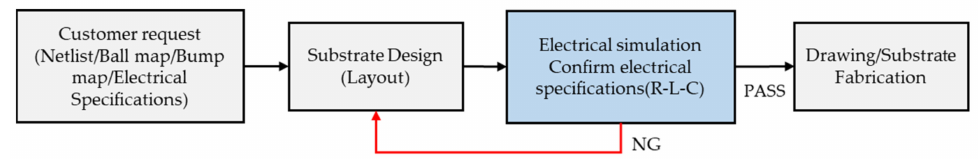
Figure 2. IC substrate generation process.